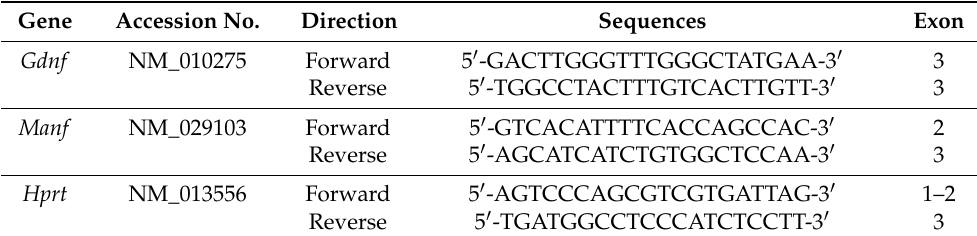
Table 1. Primer sequences used for real-time